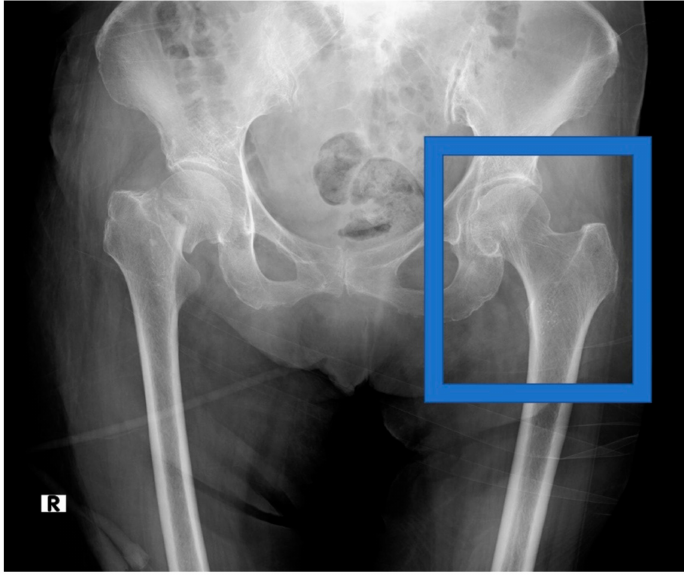
Figure 1. Hip radiograph before analysis, showing region of interest that was